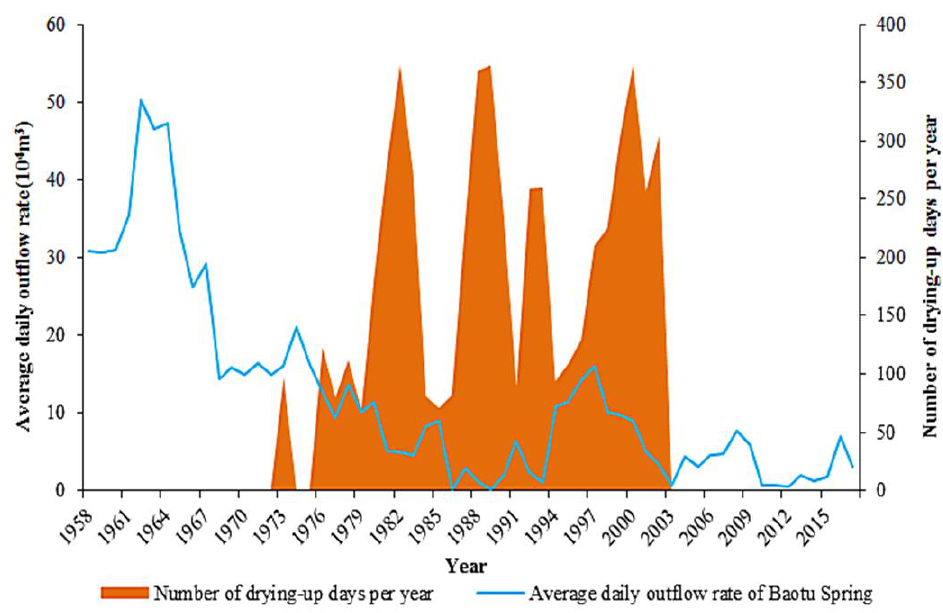
Figure 3. Outflow rate and number of drying-up days in Baotu Spring.